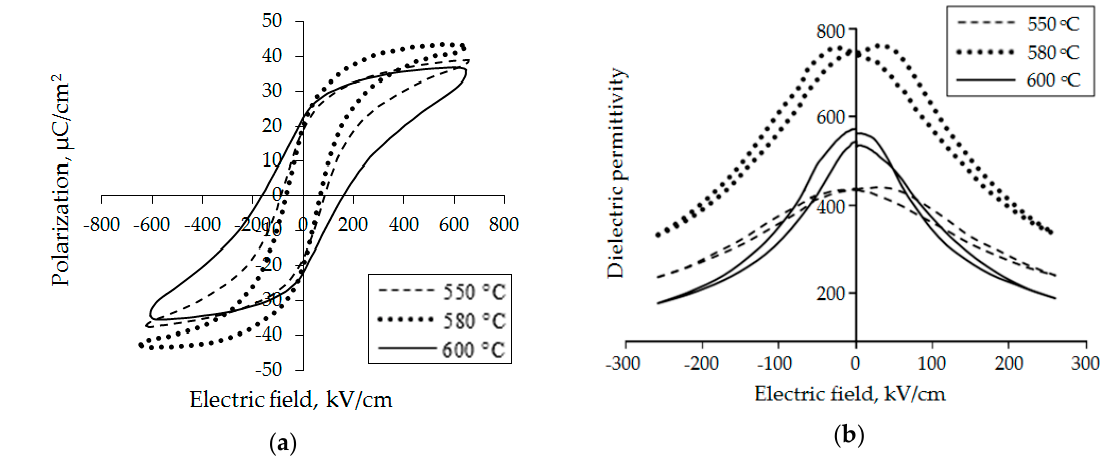
Figure 1. Characteristics of PZT filmsof 1.5 µm thickness formed at different crystallization temperatures: ( a ) hysteresis loops; ( b ) the dependences of the reversible dielectric permittivity on the electric field.